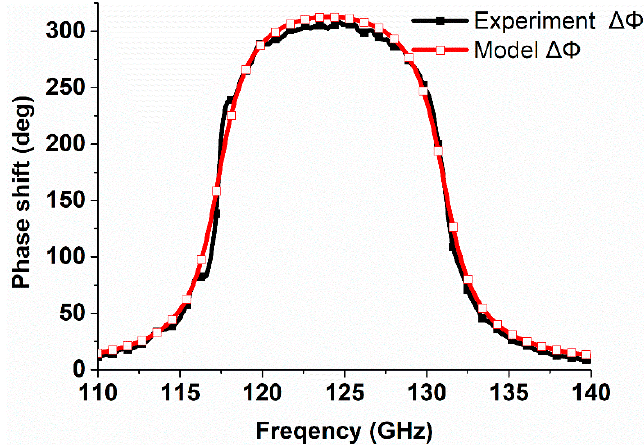
Figure 10. Comparison between the measured and simulated maximum reflection phase difference. Appl. Sci. 2018 , 8 , 2528